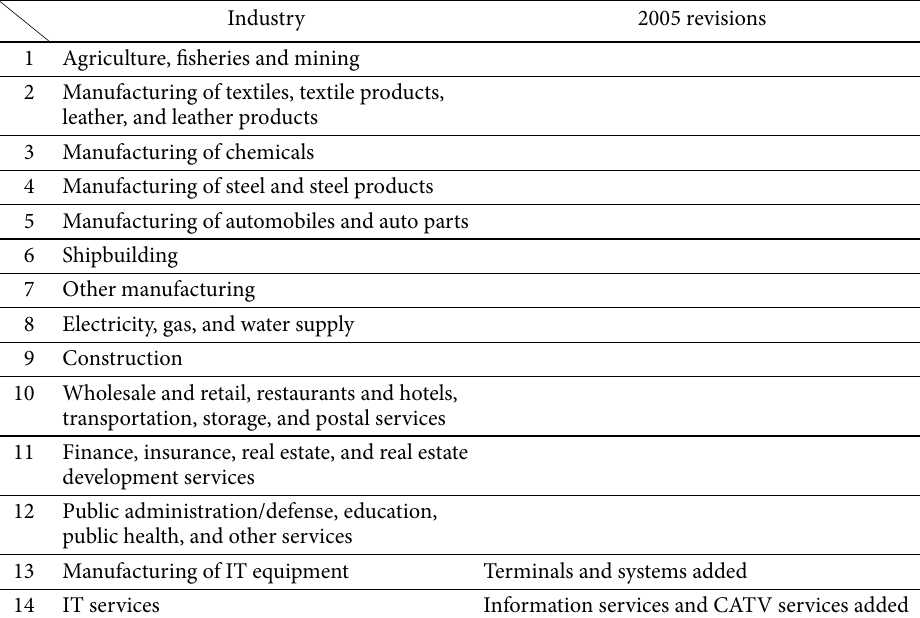
Table 1. Fourteen-category classification of Korean